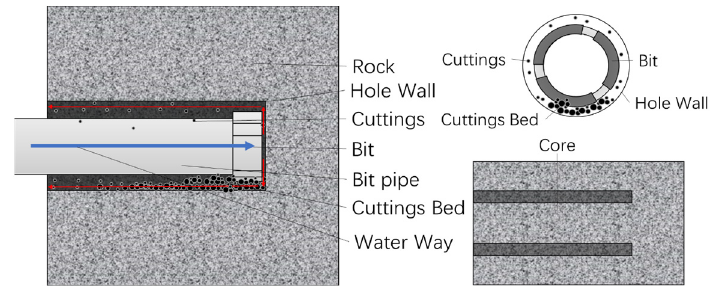
Figure 9. Internal condition of the borehole.